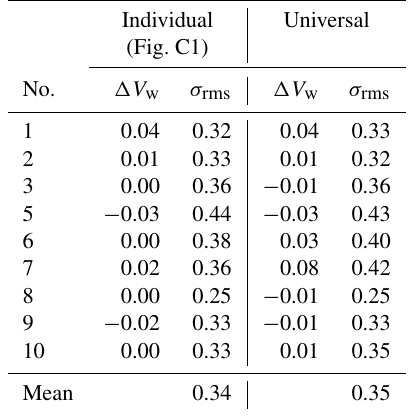
Table C1. Accuracy of wind speed measurement in meters per second (ms − 1 ) for a dataset of 34 flights (used for calibration and validation) (a) for calibration with all three parameters and (b) using only pitch offset for calibration with universal parameter values for c p and c d , 0 A 0 . The wind speed accuracy is based on 2min time-averaged data.